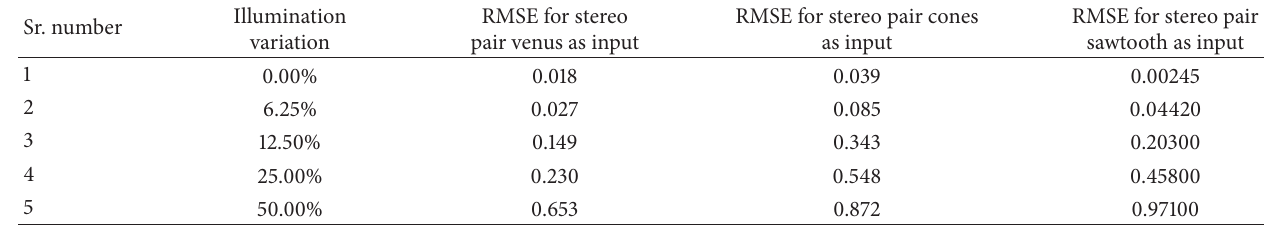
Table 3: RMSE for various illumination variations for different input stereo images. Sr. number